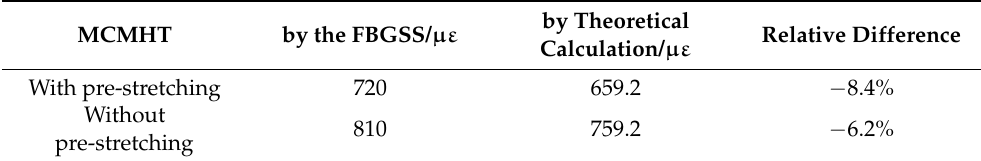
Table 4. Comparison of the residual compression strains for the two MCMHTs obtained by the FBGSS and theoretical calculation.